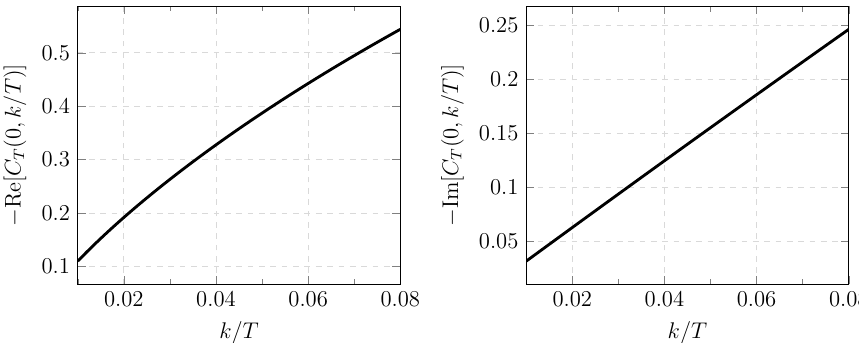
Figure 4. A plot of the (negatives of the) real and imaginary parts of Equation (51) as functions of k / T for K 2 / T 2 =